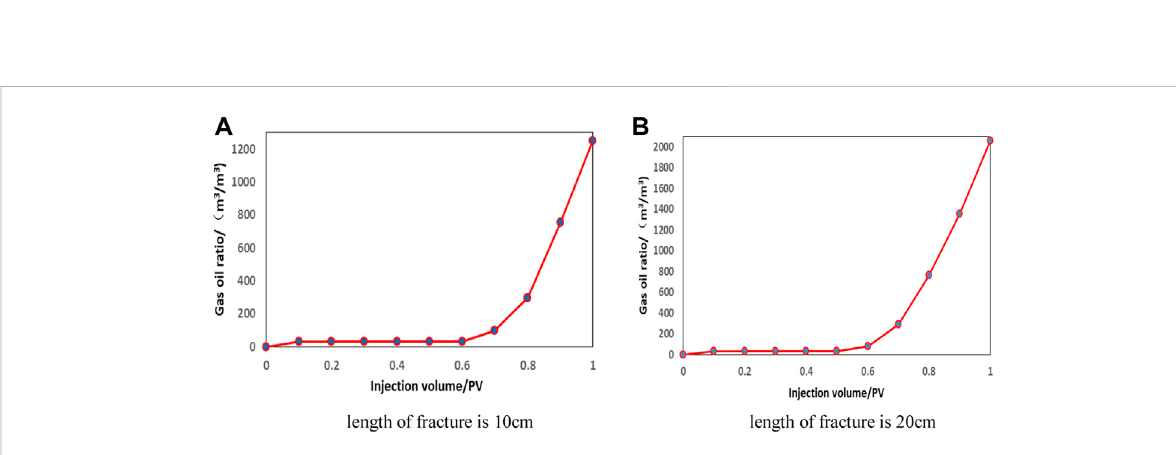
FIGURE 5 Gas oil ratio at outlet with different fracture lengths. (A) Length of fracture 10 cm and (B) length of fracture 20 cm.